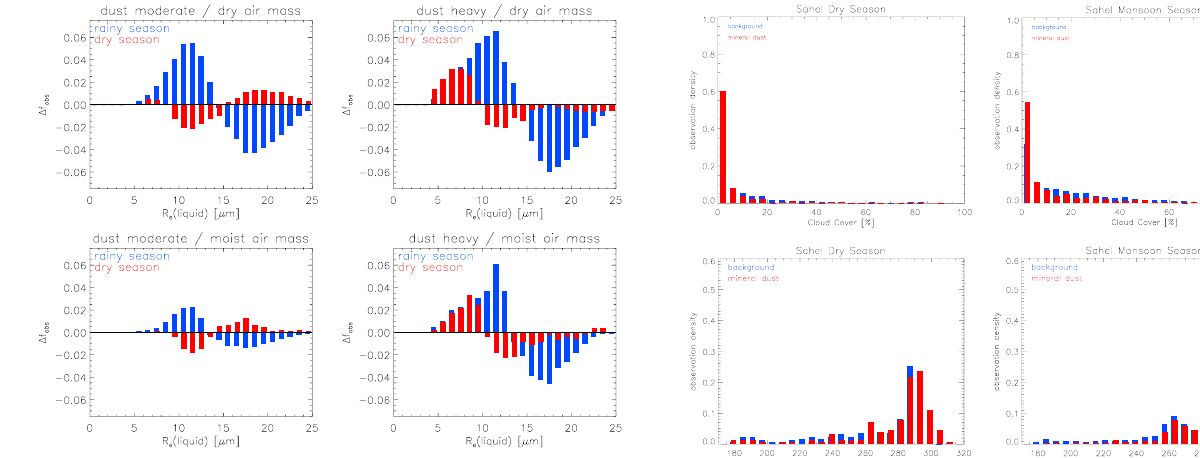
Fig. 6. Histograms of ENVISAT cloud cover (top line) and cloud top temperature (bottom line) for the Sahelian dry (left row) and wet (right row) seasons, separated into background and dust obser-